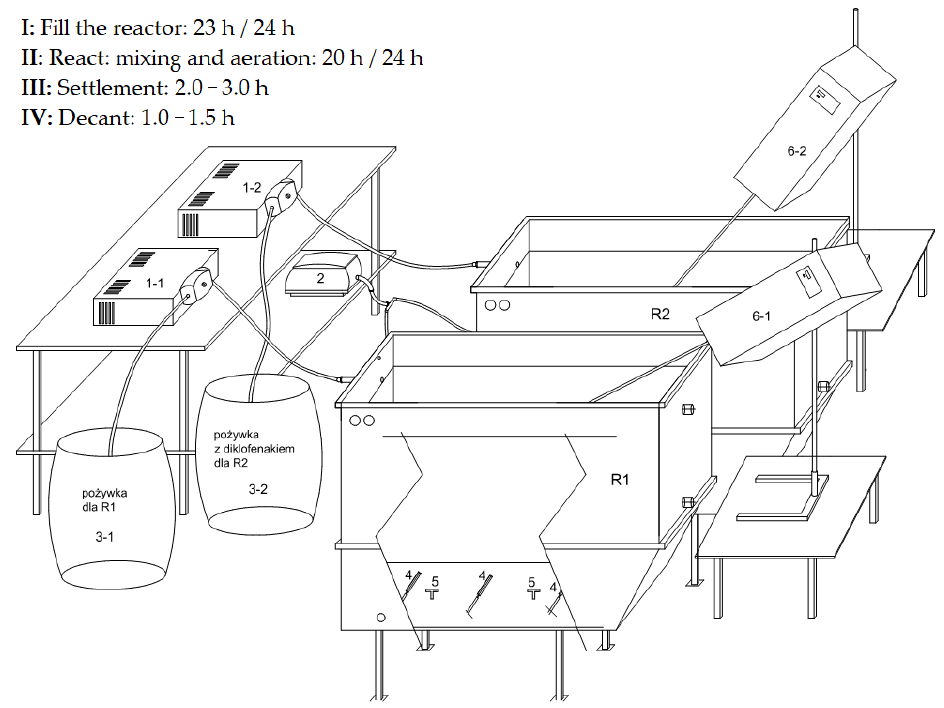
Figure 1. Scheme of the R1 and R2 bioreactor test stand: R1—oxygen bioreactor (reference reactor, without dosing diclofenac); R2—oxygen bioreactor (reactor to which diclofenac was dosed); 1–1— pump dosing the nutrient solution to the R1 reactor; 1–2—pump dosing the nutrient solution to the R2 reactor; 2—blower; 3–1 barrel with diclofenac-free medium dosed to the R1 reactor; 3–2—barrel with diclofenac-containing medium dosed to the R2 reactor; 4—fine-bubble aeration; 5—coarse-bubble aeration; 6–1—R1 reactor stirrer; 6–2-agitator of the R2